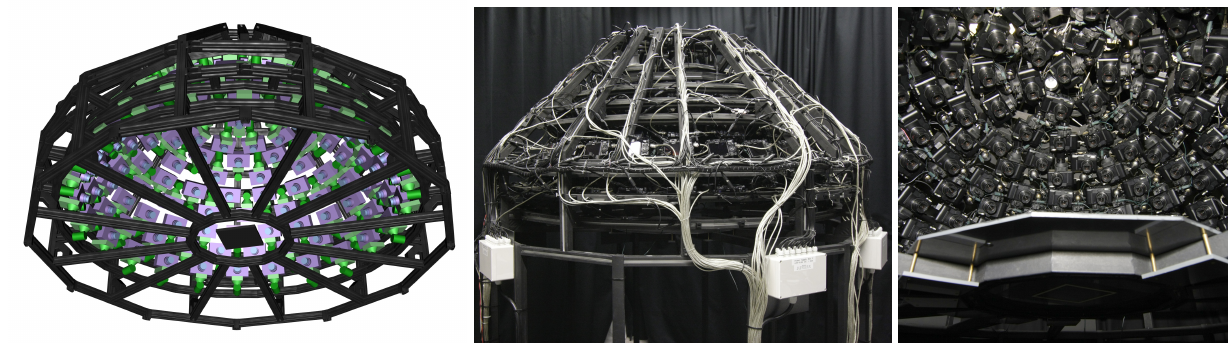
Figure 8. The Dome 1 setup as a schematic illustration ( left ) and in photographs from the outside ( center ) and inside ( right